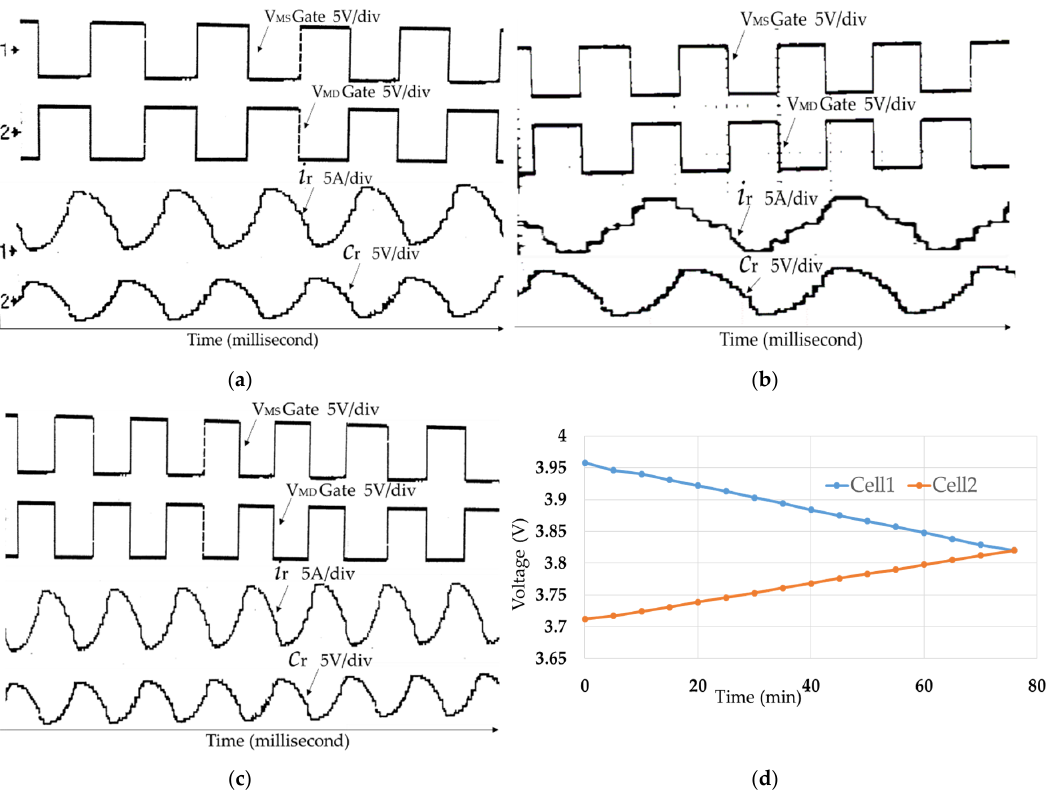
Figure 10. Experimental result waveforms with an internal resistor, ( a ) f S = fr , ( b ) f S = 2fr , ( c ) small inductor and capacitor, ( d ) measured balancing result for two Li-ion battery cell. inductor and capacitor, ( d ) measured balancing result for two Li-ion battery